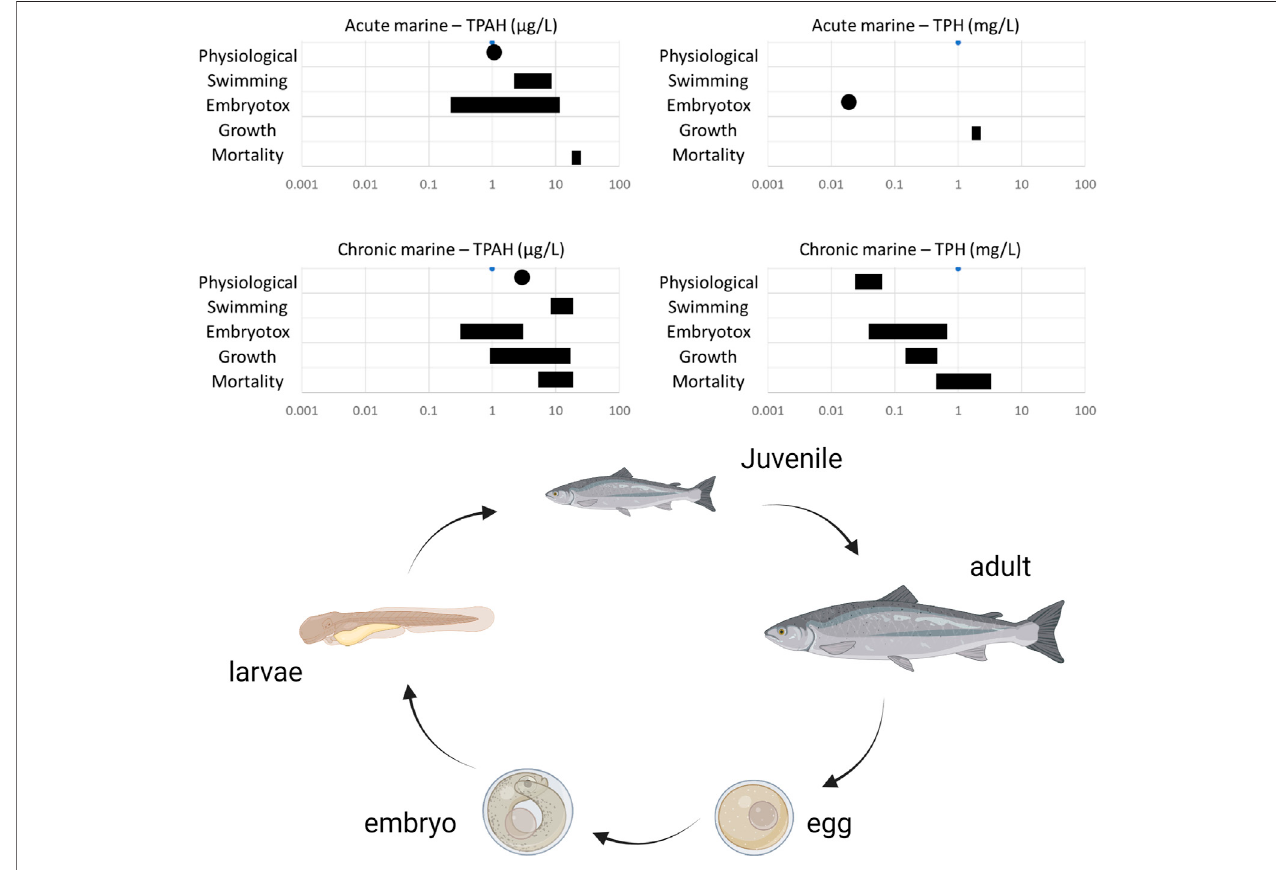
FIGURE 2 | Lethal and sublethal concentrations of TPAH and TPH for fi sh subjected to acute or chronic exposure to oil WAF (Lee et al., 2015).